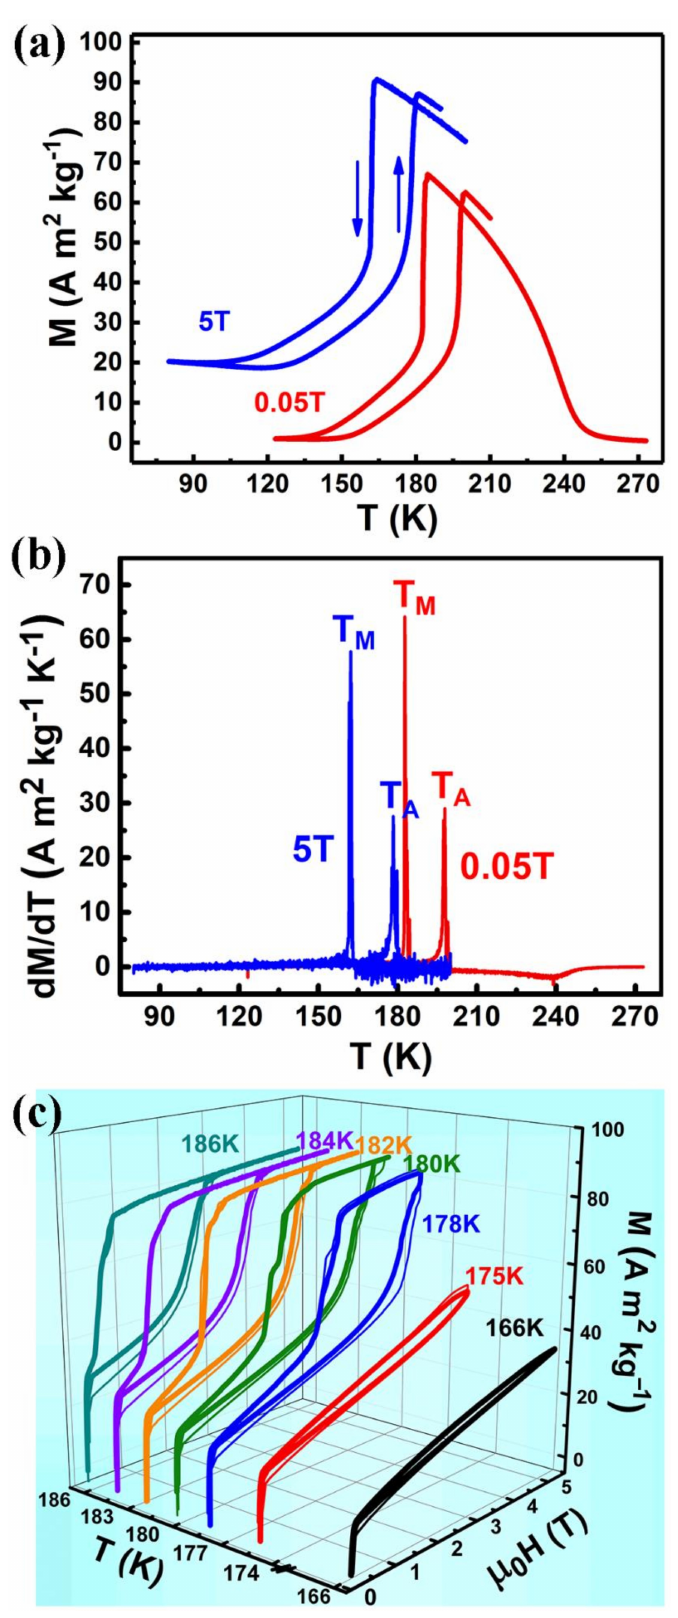
Figure 5. ( a ) M ( T ) curves measured under 0.05 T and 5 T for the Ni 50 Mn 34 Fe 3 In 13 microwire, ( b ) dM / dT derived from the curves in ( a ) shown as a function of temperature and ( c ) M ( H ) curves measured during the first (thin lines) and second (thick lines) cycles of ascending and descending magnetic fields at different constant temperatures for the Ni 50 Mn 34 Fe 3 In 13